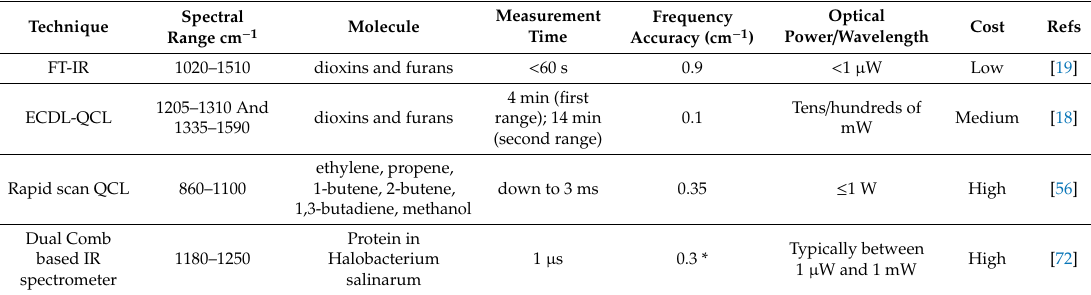
Table 3. Summary of the di ff erent optical techniques described in Section